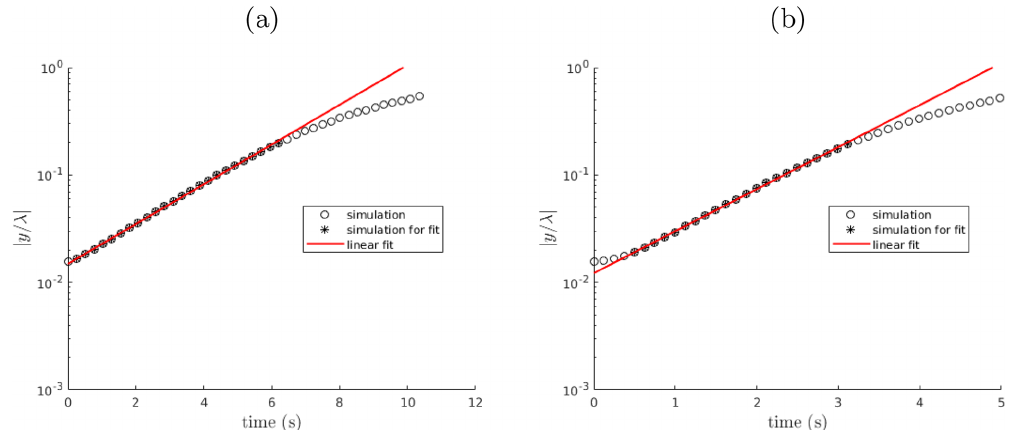
Figure A1. Time evolution of the amplitude of two single-mode perturbations ( k = 0 . 5 – a ; k = 0 . 15 – b ) for the linear Rayleigh–Taylor instability benchmark. The growth rate of the perturbation is extrapolated with a linear regression excluding data in late (physical) and eventually early (spurious) phases characterized by nonlinear effects (data not marked with an asterisk).